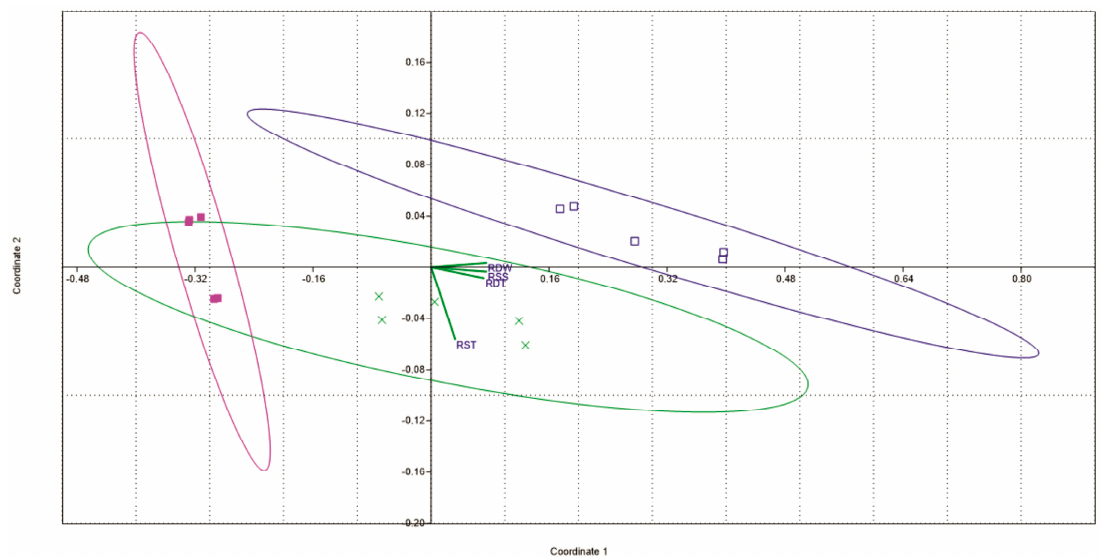
Figure 4. NMDS analysis for the three human accessibility classes (violet ellipse: EAC; green ellipse: MAC; blue ellipse: DAC), for the main indices referred to CWD (RSS, RDT, RST and RDW). EAC = easy accessibility class; MAC = medium accessibility class; DAC = difficult accessibility class; RSS = Snag/Standing volume; RDT = Downed logs/Trees; RST = Stump/Trees; RDW = CWD/standing volume.